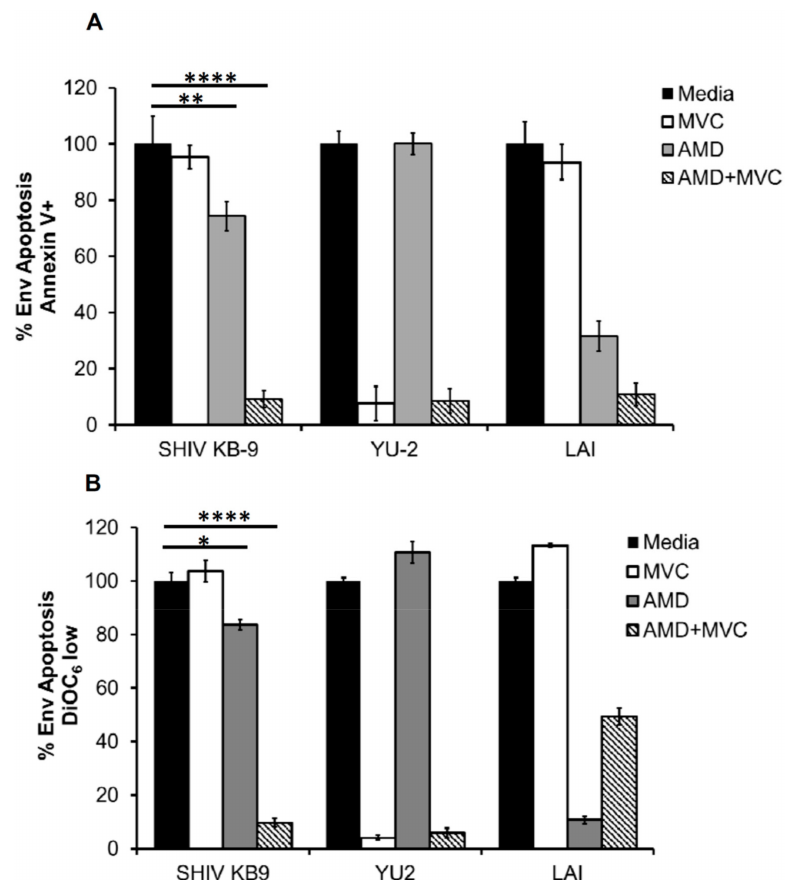
Figure5. SHIVKB9usesbothCXCR4andCCR5equallyforinductionofbystanderapoptosis. HeLacells transfected with various Envs were cocultured with SupT-R5-H6 cells. Coreceptor inhibitors AMD3100 (CXCR4) and MVC (CCR5) were used to inhibit apoptosis either alone or in combination (AMD + MVC). Apoptosis was determined 24 h later via annexin V staining ( A ) or detecting mitochondrial depolarization via DiOC6 staining ( B ). Data was normalized for each Env and percent Env specific apoptosis was calculated. Data are mean ± SD of triplicate observations. **** = p ≤ 0.0001; ** = p ≤